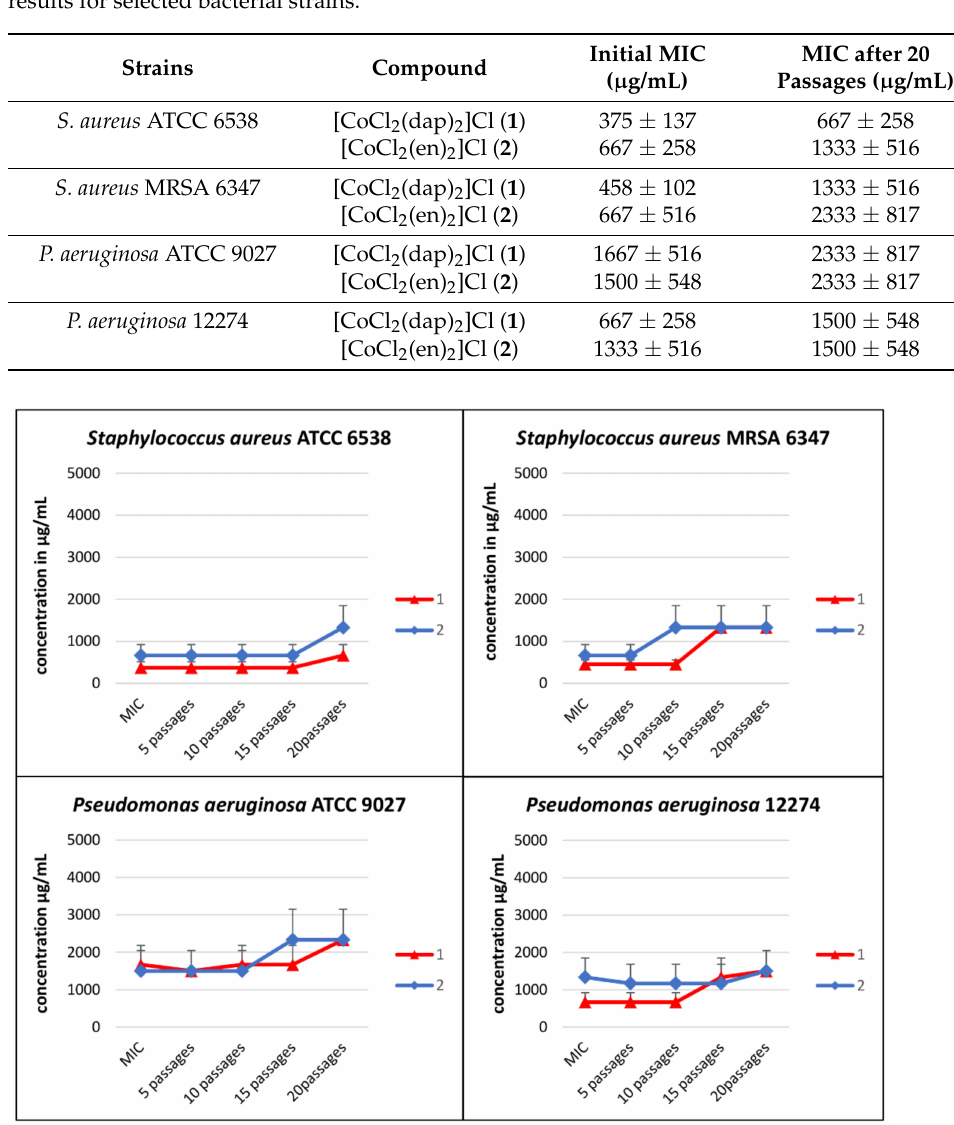
Figure 2. Serial passages assay results for the [CoCl 2 (dap) 2 ]Cl ( 1 ) and [CoCl 2 (en) 2 ]Cl ( 2 ) after 20 subsequent passages of reference and clinical strains of S. aureus and P. aeruginosa. The compounds below MIC (0.5 × MIC) were used. Data shown are mean ±